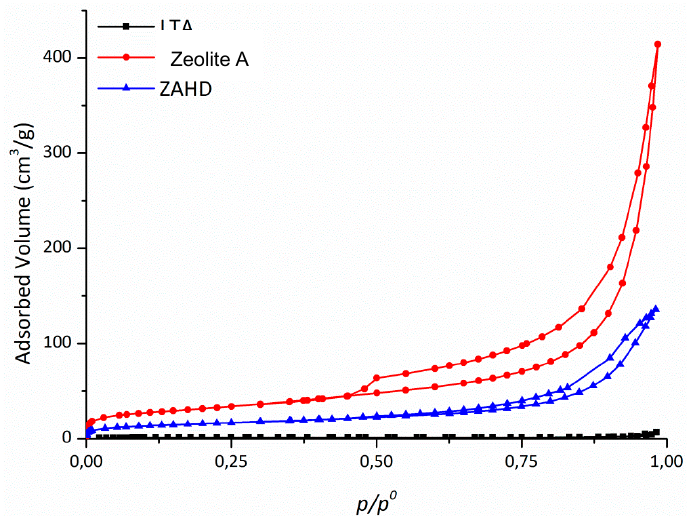
Figure 4. N 2 isotherms of the synthesized samples: LDH, zeolite A, and ZAHD composite. Table 2. Textural results for the synthesized materials.